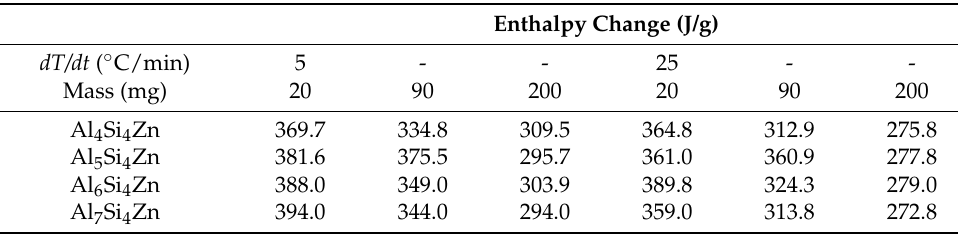
Table 3. Enthalpy change for the melting transformation for the alloys studied here when heated at 5 and 25 ◦ C/min with different sample masses.